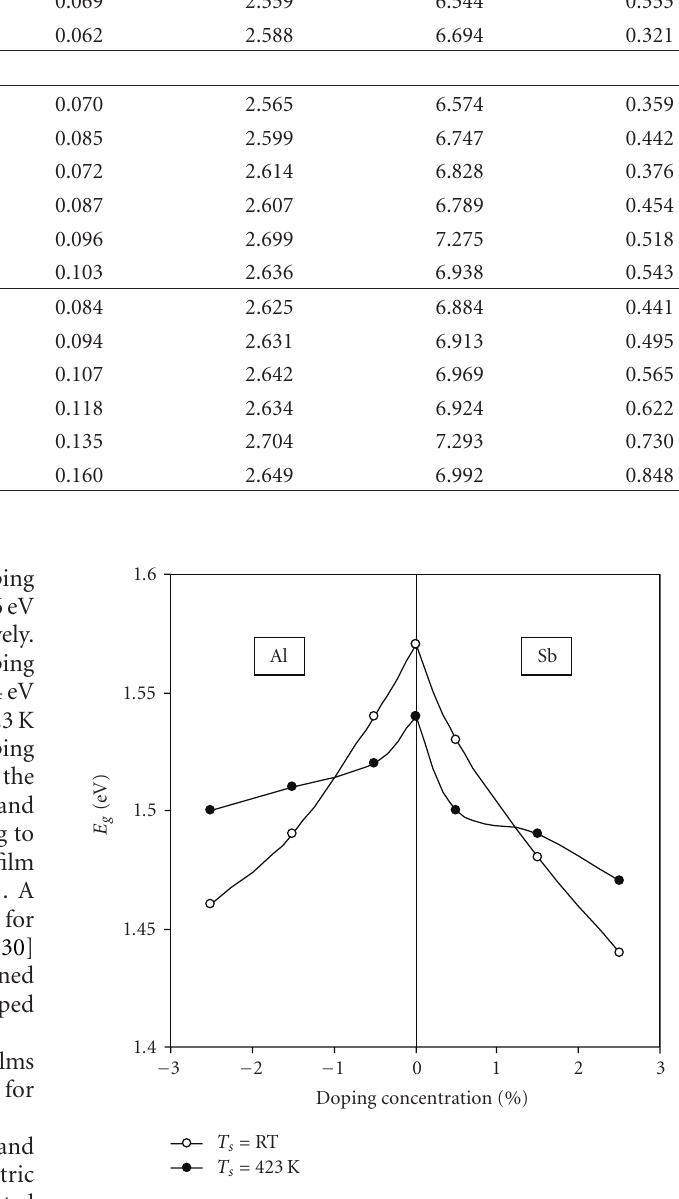
Figure 2: Variation of E g with dopant percentage concentrations of Al and